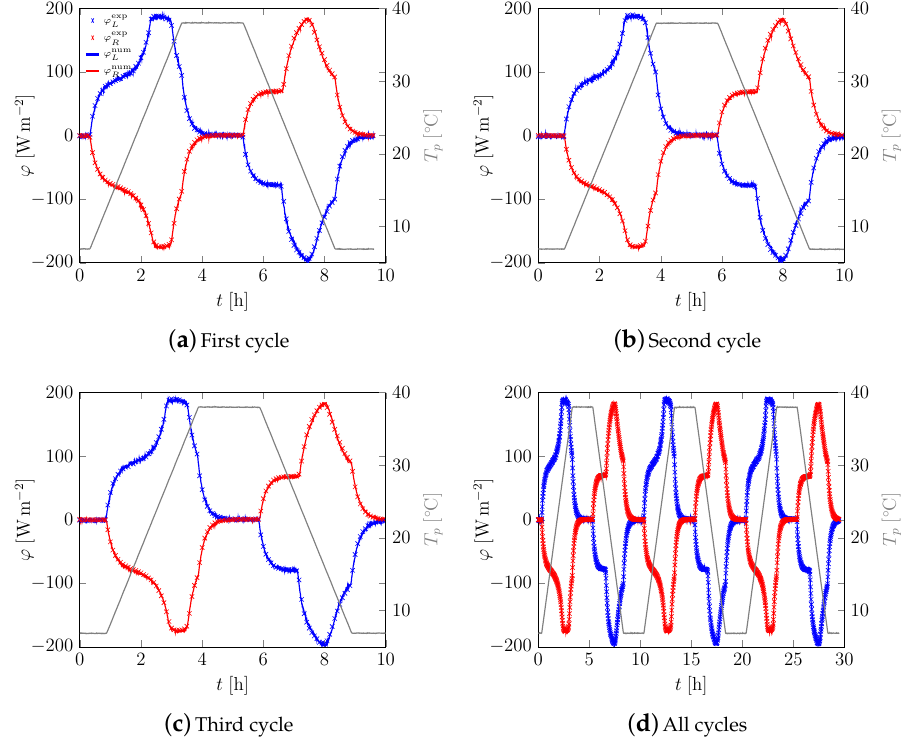
Figure A9. 22.1% w -PCM mortar: comparisons of the experimental fluxes with the numerical ones after identification for the 3h heating/cooling ramp